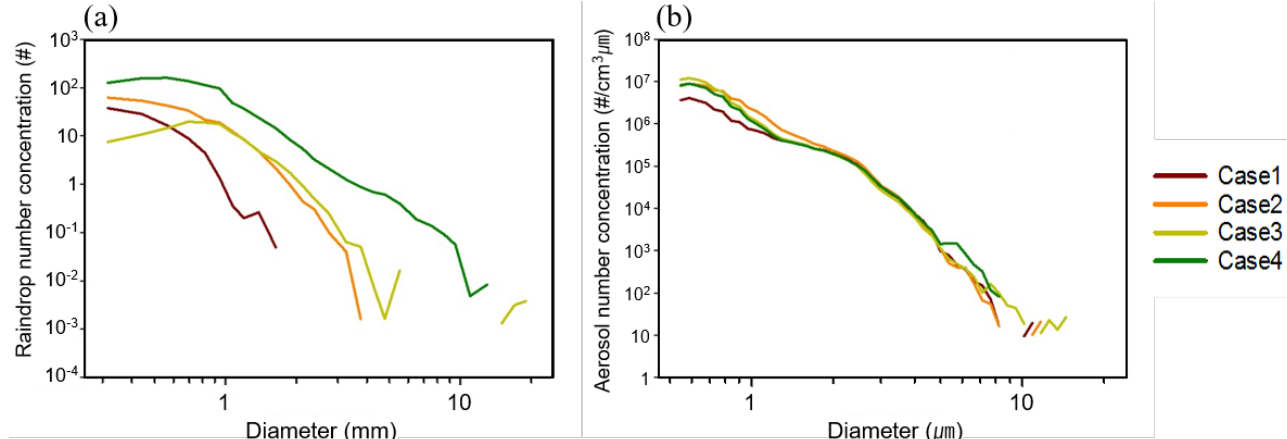
Figure 1. The number concentration of ( a ) raindrop and ( b ) aerosol in Cases 1 to 4.